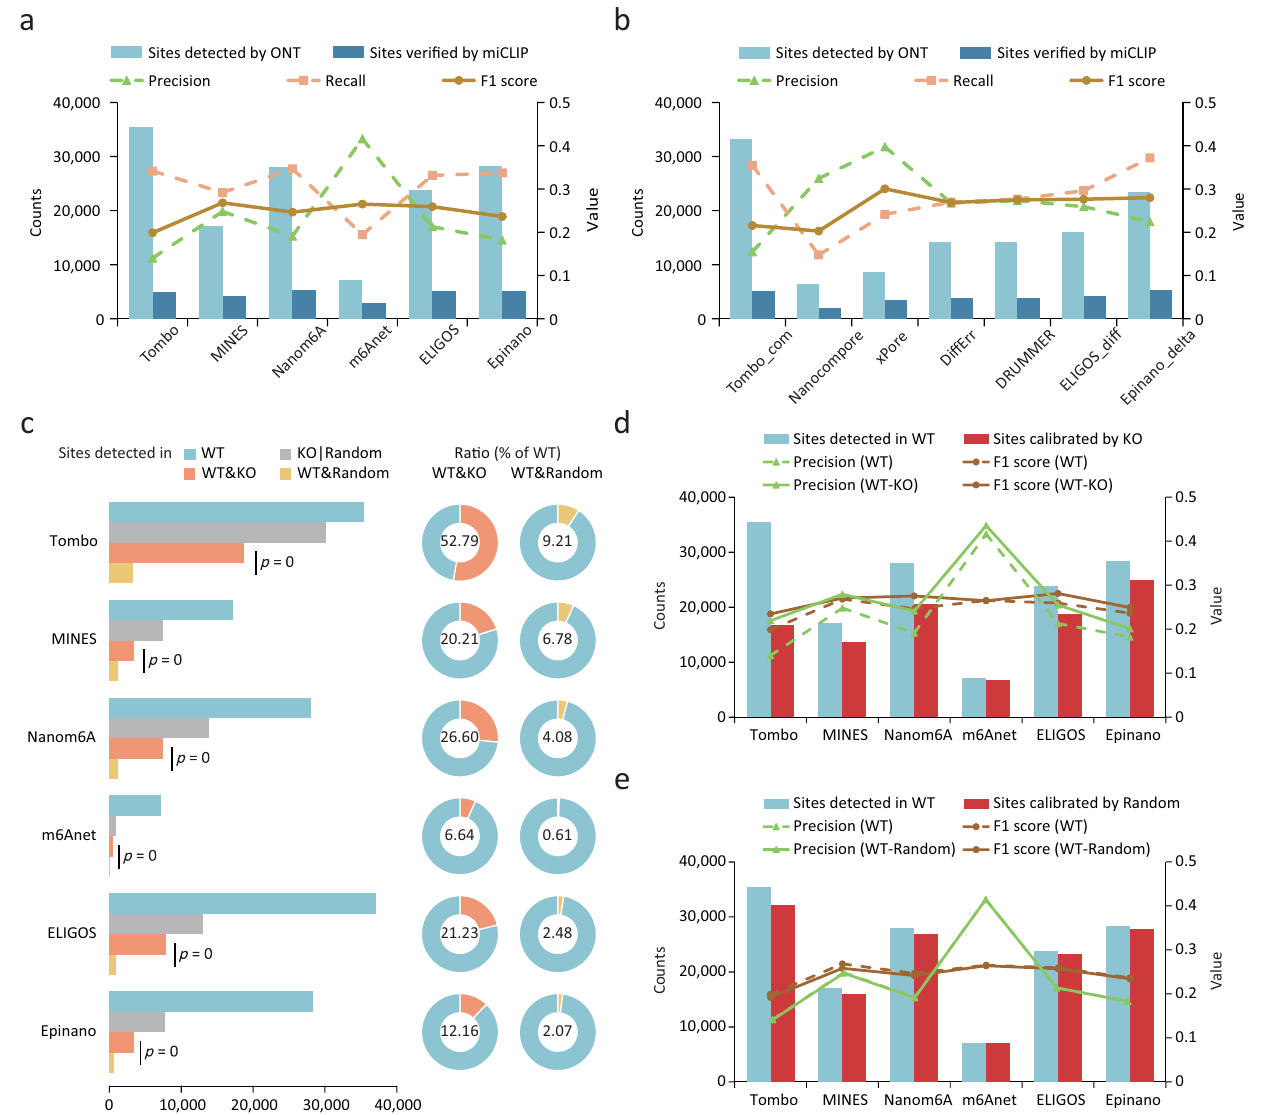
Random. d , e The m6A site counts and precision and F1 scores before and after calibrationwiththeresultsfromKO( d )orrandom( e )samples.miCLIPresultswere usedasavalidationset.WT-KO,precisionandF1scoreforsitescalibratedusingKO results. WT-random, precision and F1 score for sites calibrated with a randomly selected